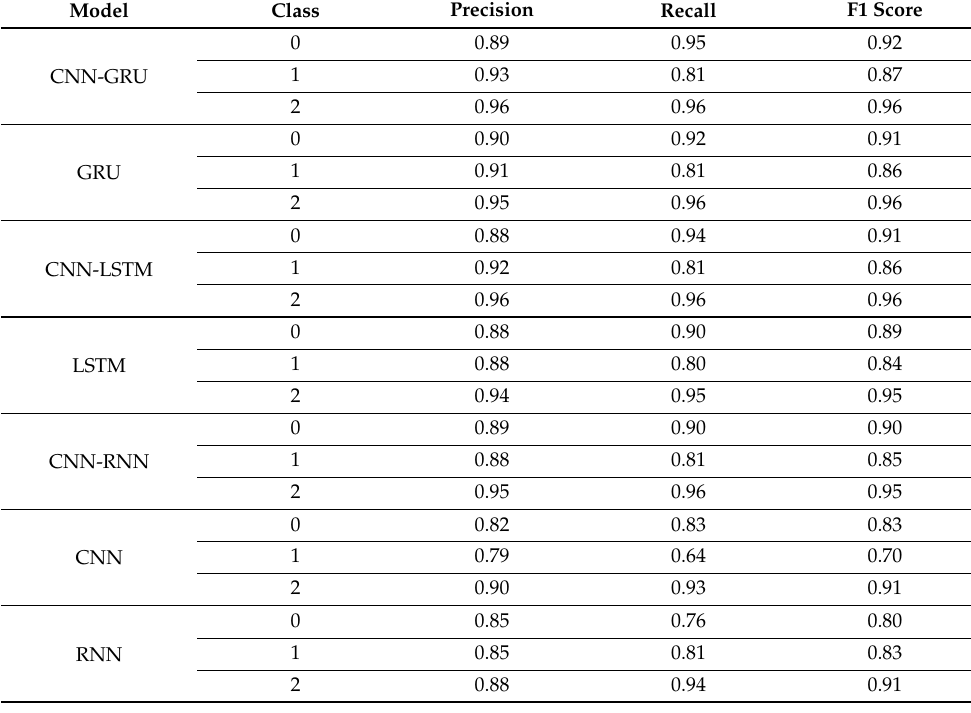
Figure 6. Confusion matrices: ( a ) SVM and ( b ) CNN-GRU. Table 17. The per class score for the deep-learning models. Model Class Precision Recall F1